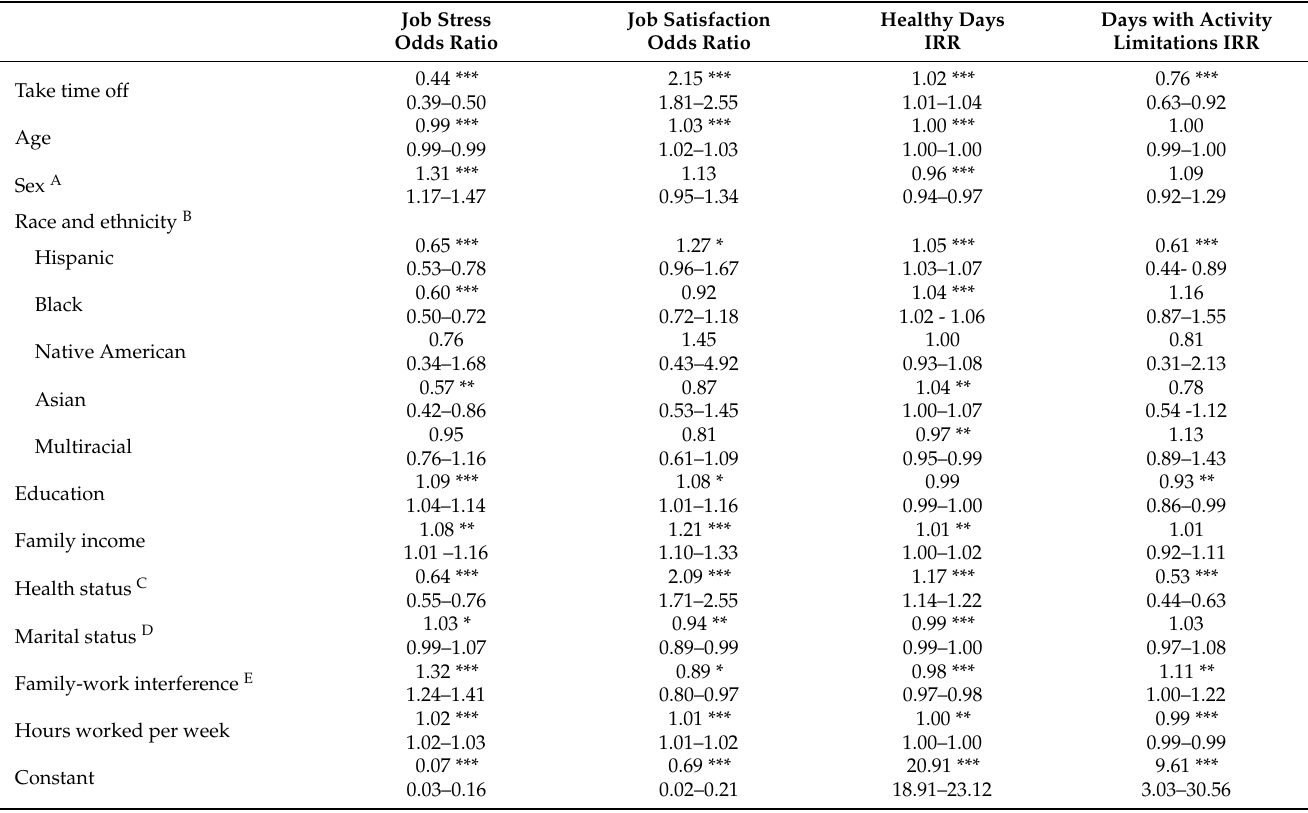
Table 6. Ability to take time off and well-being, pooled GSS-QWL